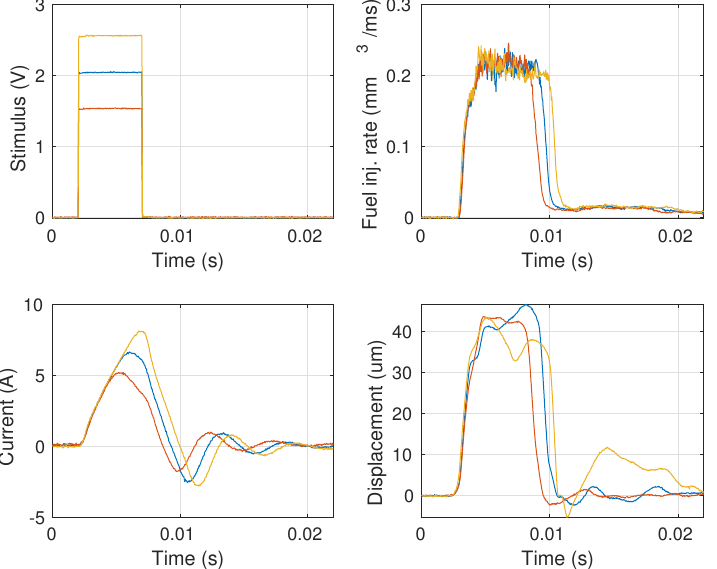
Figure 8. Comparison of measured signals with squared reference and different amplitudes, with t inj = 5 ms and P inj = 50